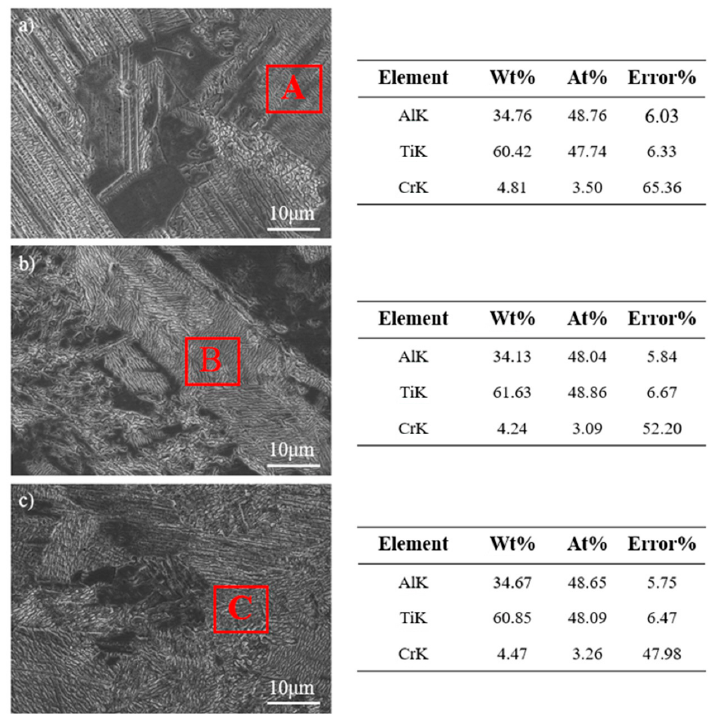
Figure 4. EDS analysis of the lamellar structure of the Ti-48Al-2Cr alloy solidified under different pressures. ( a ) ambient pressure, 1873 K; ( b ) 5 GPa, 1873 K; ( c ) 5 GPa, 1973 K.